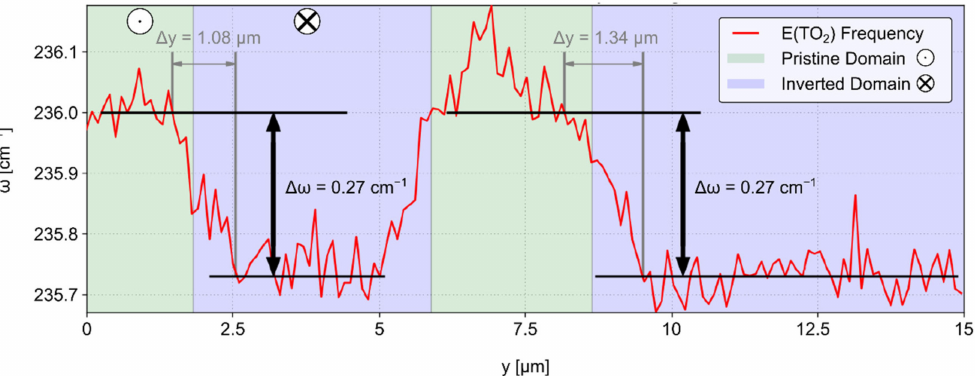
Figure 11. Line scan of the E(TO 2 ) phonon frequency over poled TFLN domains. A sample section with large domains has been chosen for a clear visualization of the phonon frequency shift between pristine and inverted domains, which are highlighted in blue and green as a guide to the eye. The analyzed DW interaction length ∆ y is larger than the resolution limit, suggesting long-range stress fields in the vicinity of the